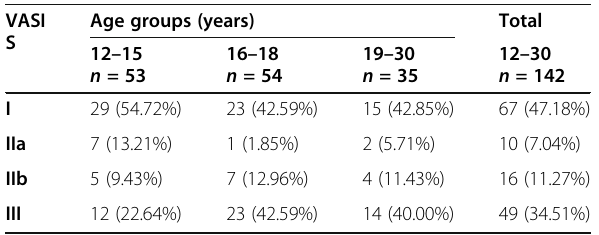
Table 1 Descriptive statistics of VASIS categories according to